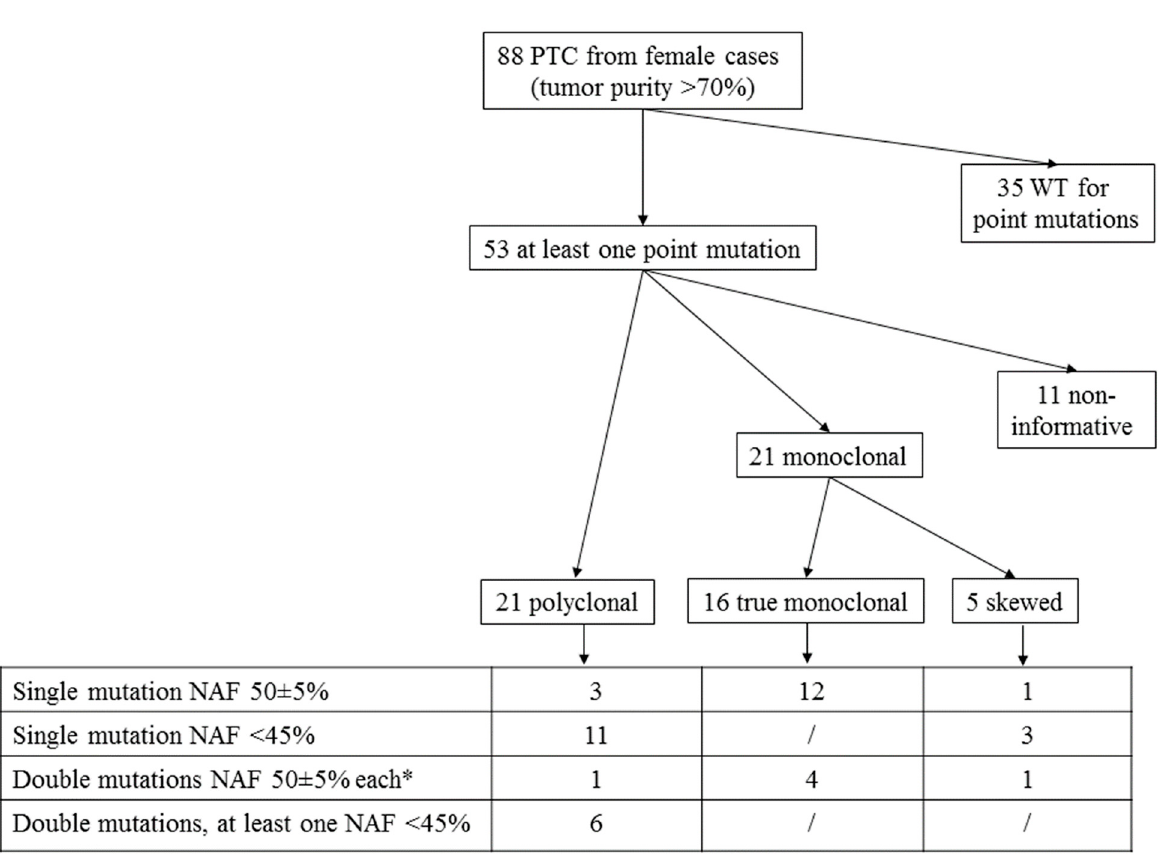
Figure 1. Case selection and results of HUMARA clonality assay. NAF: normalized allelic frequency. * One case had one mutation with NAF 50% and the other with NAF 80% likely indicating the loss of heterozygosity (LOH) of the wild type allele.